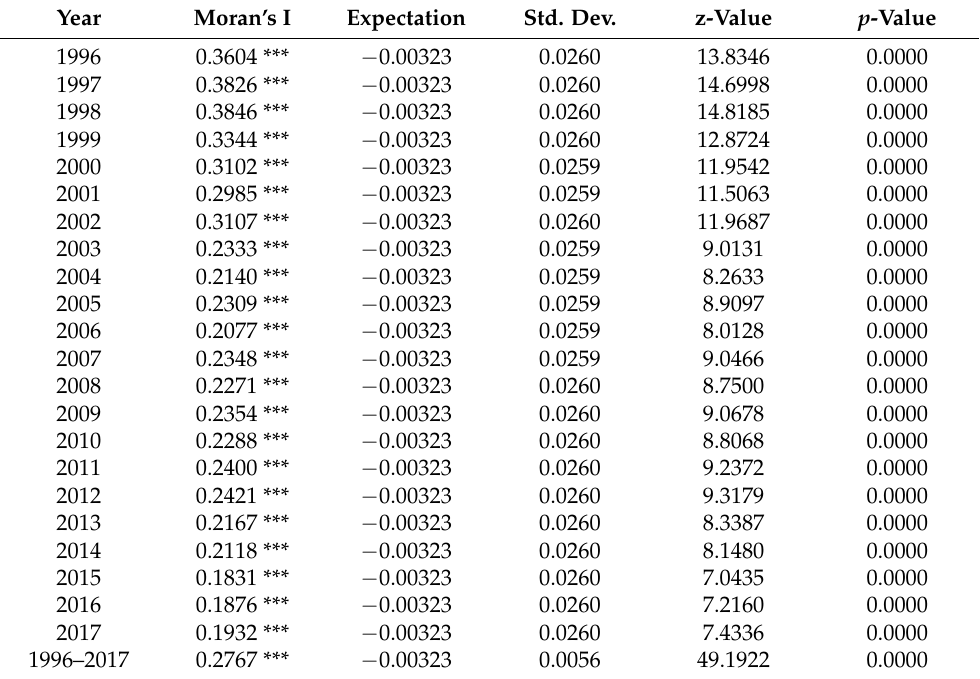
Table 4. Global Moran’s I statistical indexes of 306